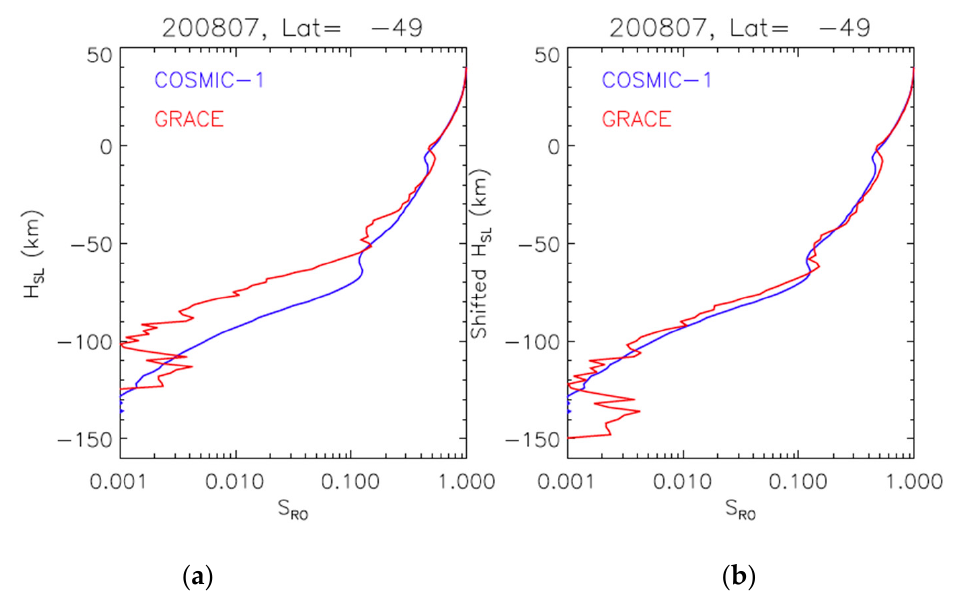
Figure 5. The mean S RO profiles from COSMIC-1 and GRACE from July 2008 when their orbital altitudes were respectively at 810 and 350 km: ( a ) as a function of H SL , ( b ) as a function of ˆ H SL .